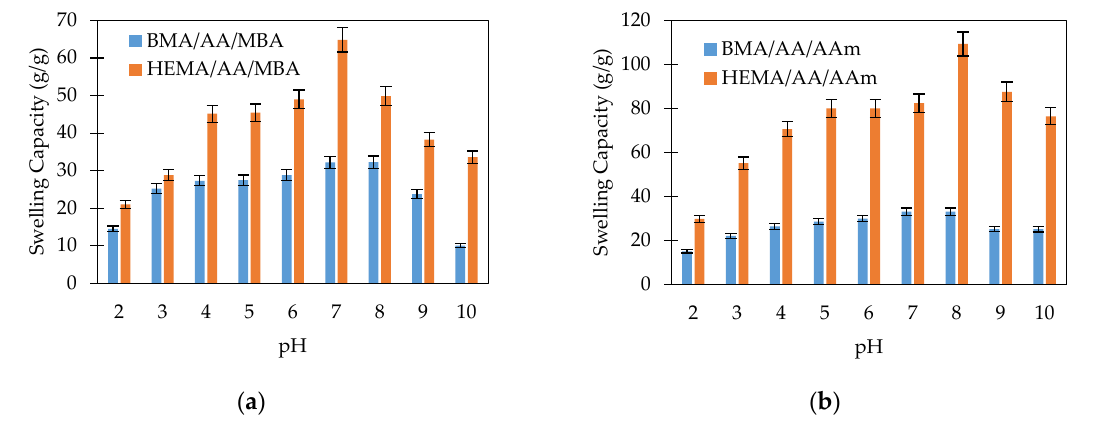
Figure 6. Swelling capacity of the hydrogels as a function of the pH. Effect of the hydrophilic/hydrophobic monomers: ( a ) Comparison of BMA/AA/MBA and HEMA/AA/MBA hydrogels; ( b ) Comparison of BMA/AA/AAm and HEMA/AA/AAm hydrogels.